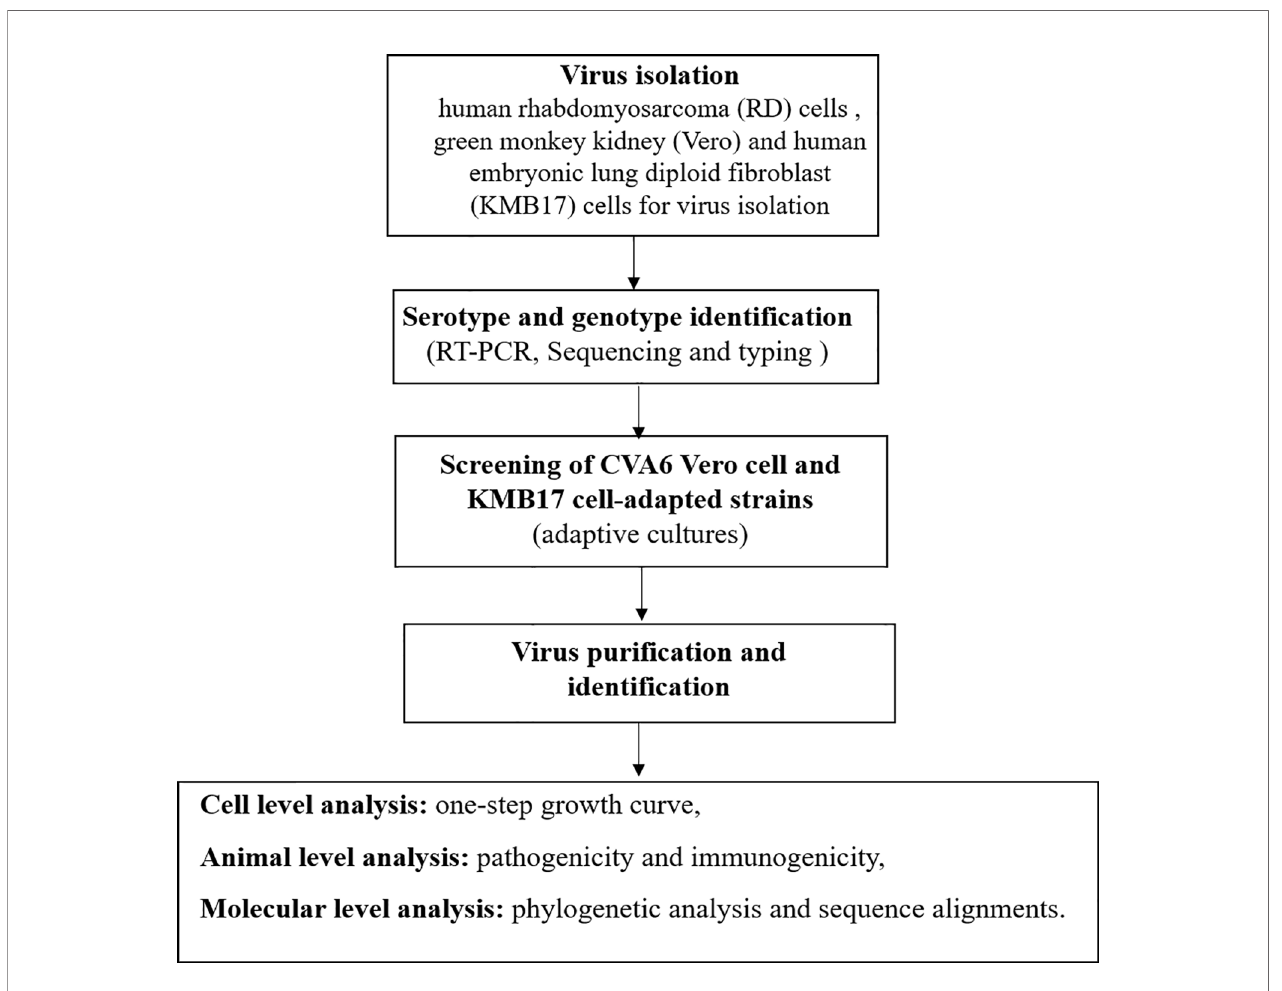
FIGURE 1 | The fl ow chart of the